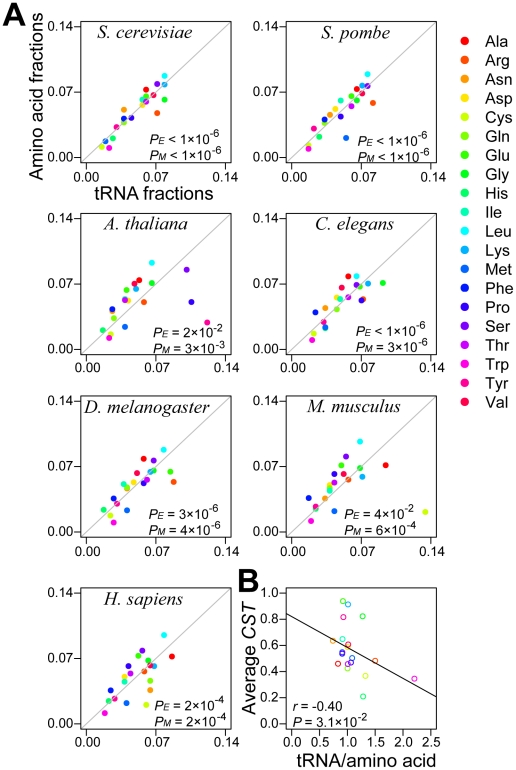
Amino acids are used approximately in proportion to cognate tRNA concentrations.(A) Relative uses of amino acids estimated from the transcriptomic data of 7 model eukaryotes are compared to the relative concentrations of their cognate tRNAs measured from gene copy numbers. The diagonal line shows the predicted proportional relationship between tRNA concentrations and cognate amino acid frequencies that maximizes translational efficiency under tRNA shortage. PE (or PM) is the probability that the Euclidian (or Manhattan) distance between the amino acid usage randomly generated under a uniform distribution and that predicted by the proportional rule is smaller than the observed distance, and is estimated from 106 simulations. The distance definitions are the same as those in the legend of Figure 2, except that i is an amino acid instead of a codon. (B) The average CST of an amino acid in S. cerevisiae is negatively correlated with the availability of its cognate tRNAs, which is measured by the fraction of cognate tRNA genes among all tRNA genes divided by the frequency of the amino acid estimated from the transcriptome. The P-value is determined from 1000 permutations of CSTs.